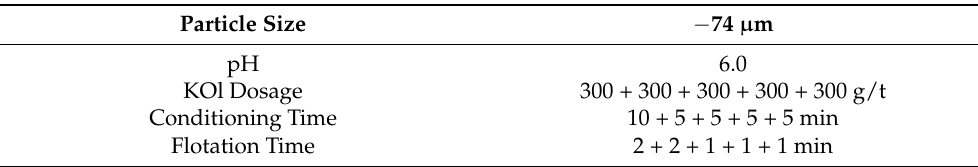
Table 2. The conditions of the flotation